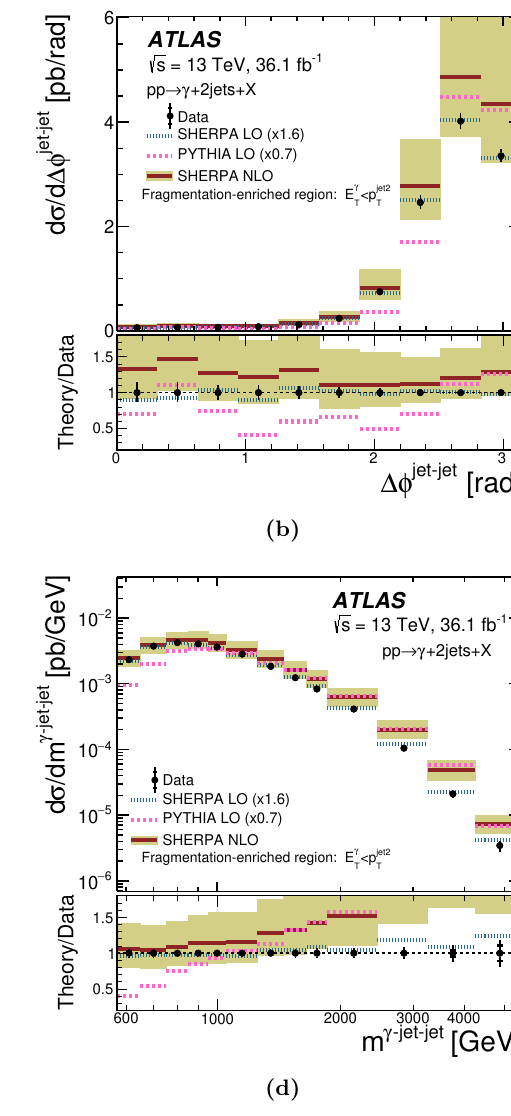
Figure 7 . Measured cross sections for isolated-photon plus two-jet production (dots) as functions of (a) j (cid:1) y jet{jet j , (b) (cid:1) (cid:30) jet{jet , (c) m jet{jet and (d) m (cid:13) {jet{jet for the fragmentation-enriched phase space. The NLO QCD predictions from Sherpa (solid lines) based on the NNPDF3.0 PDFs are also shown. The tree-level plus parton-shower predictions from LO Sherpa (dotted lines) and Pythia (dashed lines) normalised to the integrated measured cross section (using the factors indicated in parentheses) are also shown. The bottom part of each (cid:12)gure shows the ratio of the predictions to the measured cross section. The inner (outer) error bars represent the statistical uncertainties (the statistical and systematic uncertainties added in quadrature) and the (cid:12)lled bands represent the theoretical uncertainty of the NLO QCD predictions. For most of the points, the inner and outer error bars are smaller than the marker size and, thus, not visible. The visible thin error bars represent the outer error